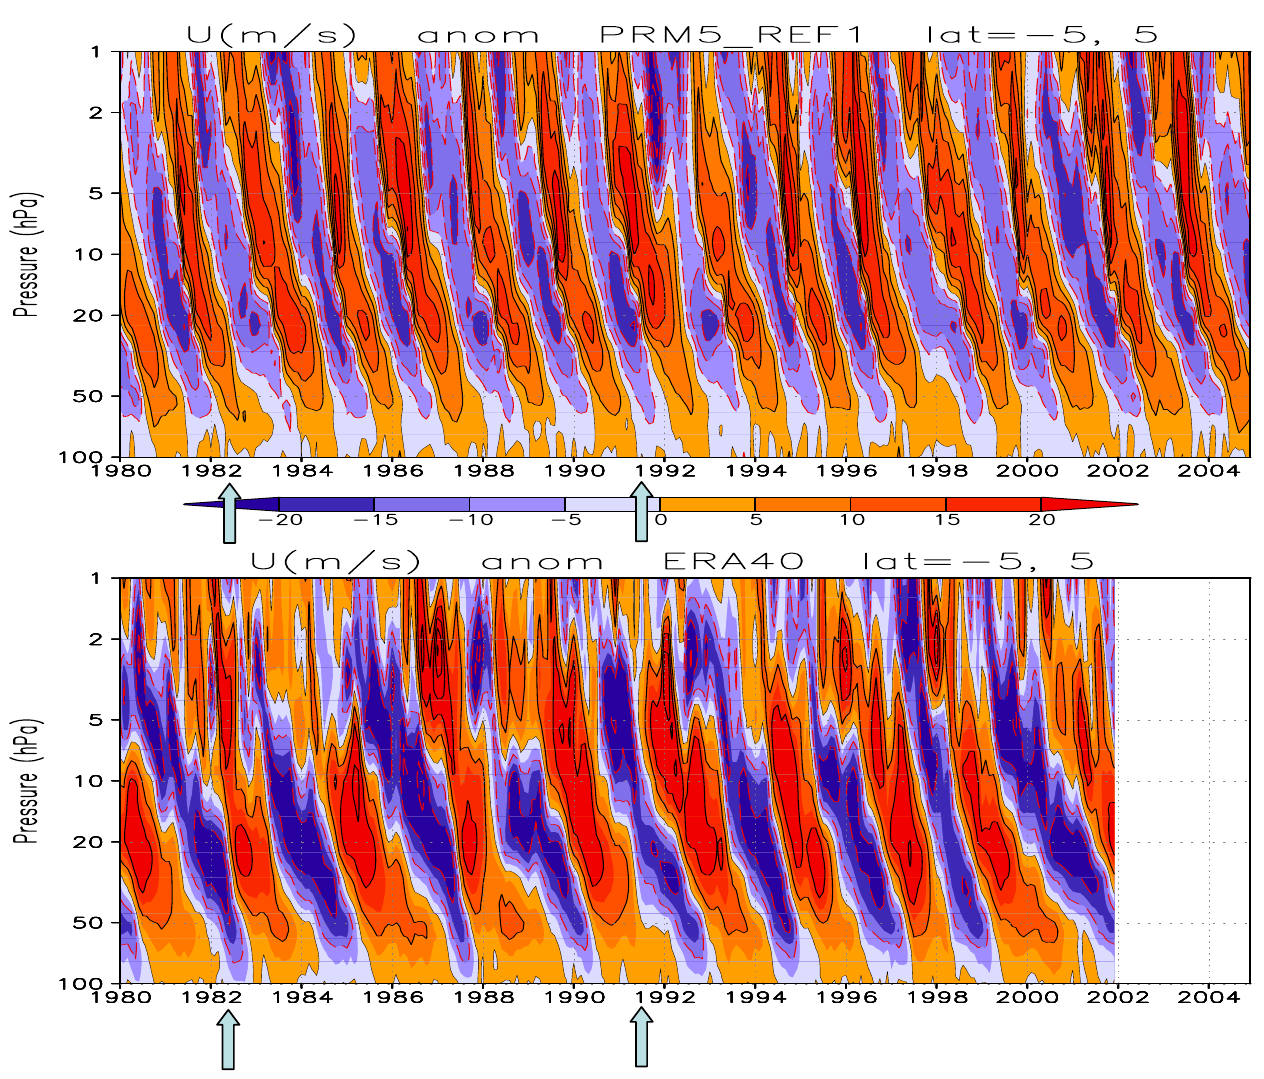
Fig. 2. Evolution of the deseasonalized zonal-mean zonal wind averaged between 5 ˚ S and 5 ˚ N from 100 to 1 hPa for the simulation (upper) and observation (ERA-40) (lower). Color shading is the same for both panels, but the contour interval is 5 m/s for the simulation and 10 m/s for the observation. Arrows represent the eruption dates of El Chichón and Mount Pinatubo.